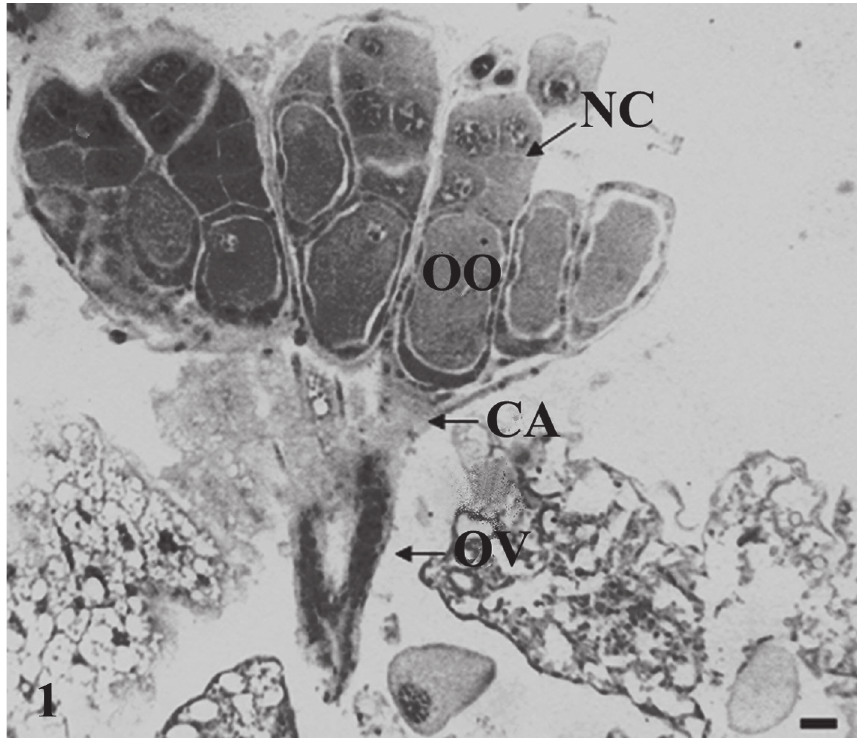
Figure 1 - Ovary of a newly-emerged females of Palmistichus elaeisis (Hymenoptera: Eulophidae) from Tenebrio molitor (Coleoptera: Tenebrionidae) pupae: OO- oocyte, NC- nurse cell CA- calyx, OV- lateral oviduct. Bar: